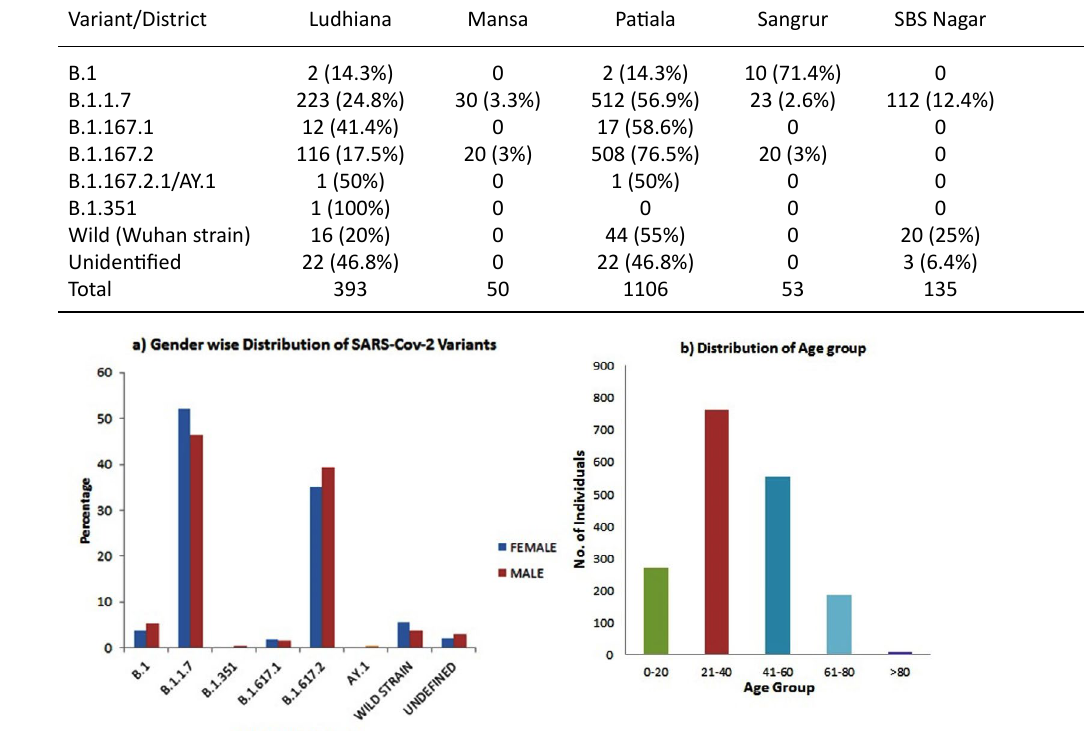
table 2. Distribution of SARS-CoV-2 variants during the time period of January 2021 to May 2021 in different geographic regions of Punjab (Data provided in supplementary sheets) Variant/District